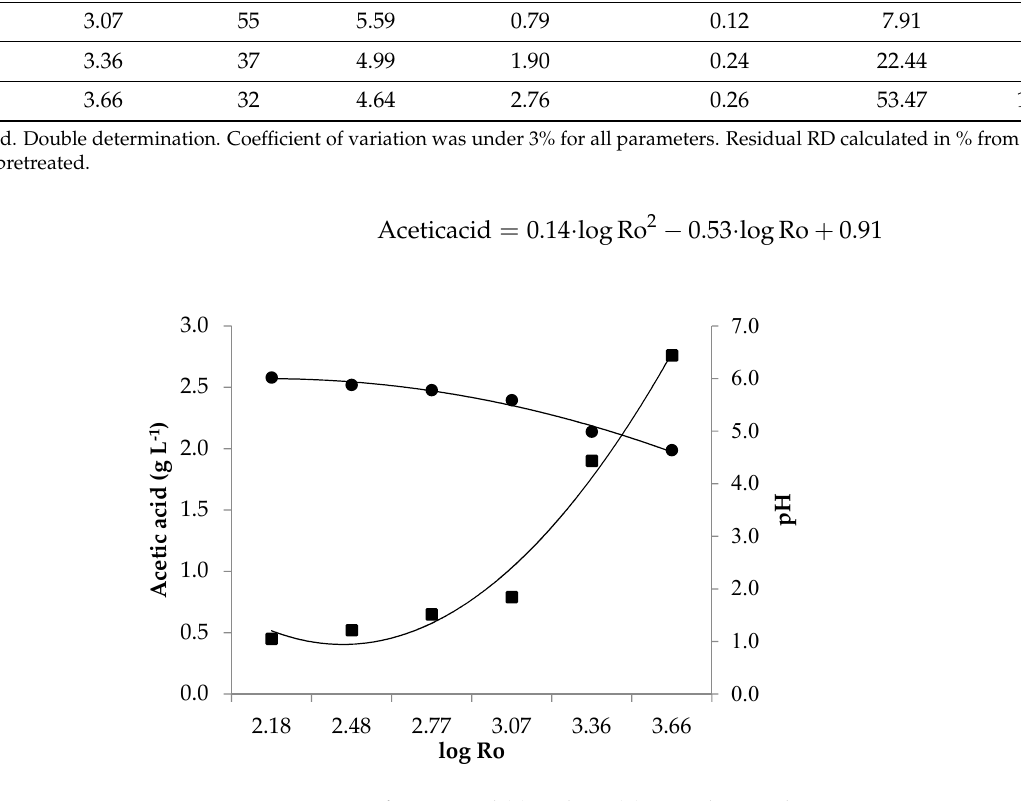
Figure 2. Composition of acetic acid ( ■ ) and pH ( ● ) according to the pretreatment severity (log Ro). A similar performance was observed by López González, et al. [12], who reported acetic acid concentrations of 0.4 g L − 1 for log Ro = 2.17 (150 °C for 5 min) and 1.6 g L − 1 for log Ro = 2.49 (175 °C for 2 min). Acetic acid (and other organic acids) is the by-product of hemicellulose O-acetyl groups (glucuronide conjugates) hydrolysis [13]. H + ions from those acids lowered the pH from 6.02 to 4.64 (Table 2 and Figure 2). Furan compounds (HMF and furfural) were found in the liquid fraction, formed at 160 and 180 ◦ C with a marked increase at 180 ◦ C. The maximum furfural concentration of 149.40 mg L − 1 determined (equivalent to 1.26 mg g − 1 TS) was greater than that reported by Wang, et al. [18] for pretreated RS at 180 ◦ C for 15 min (0.6 mg g − 1 TS). The maximum furfural production (2800 mg L − 1 ) for pretreated RS was demonstrated at higher temper- ature (200 ◦ C for both 10 and 30 min), corresponding to a complete or nearly complete degradation of xylose and arabinose [31]. In the case of HMF concentrations, a maximum value of 53.47 mg L − 1 at log Ro = 3.66 (180 ◦ C for 20 min) was observed (Figure 3). This agrees well with results described by Wu, et al. [30], who found low concentrations of HMF for pretreated RH at log Ro = 3.35 (180 ◦ C, 10 min) and log Ro = 3.65 (190 ◦ C, 10